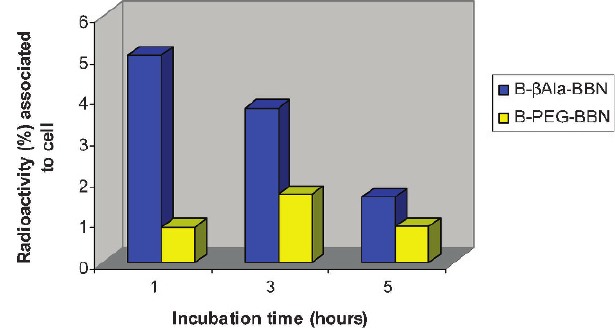
Figure 7 - Total binding to PC-3 cells of the mixtures plus 99m Tc- MAG 3 -cMORF.